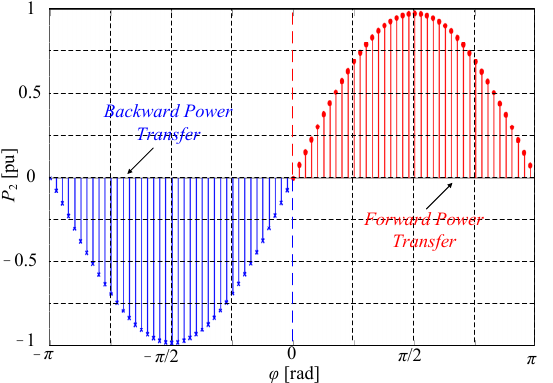
Figure 4. The output power with respect to phase shift angle φ .